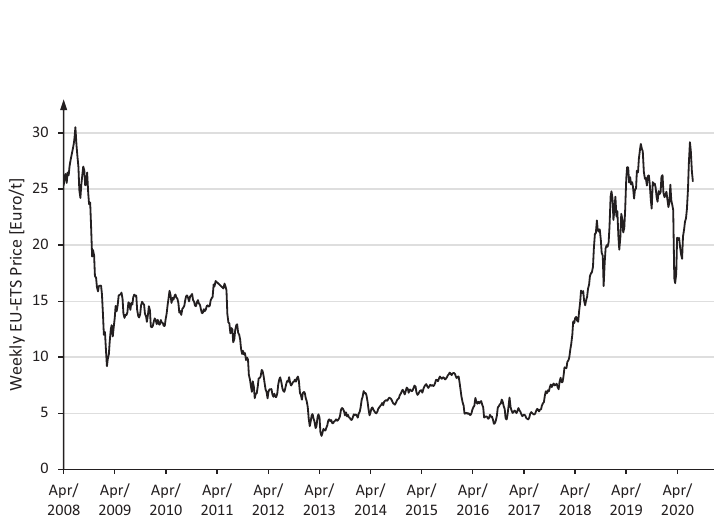
Fig. 4. – Weekly EU-ETS Price since 2008 (Data source: